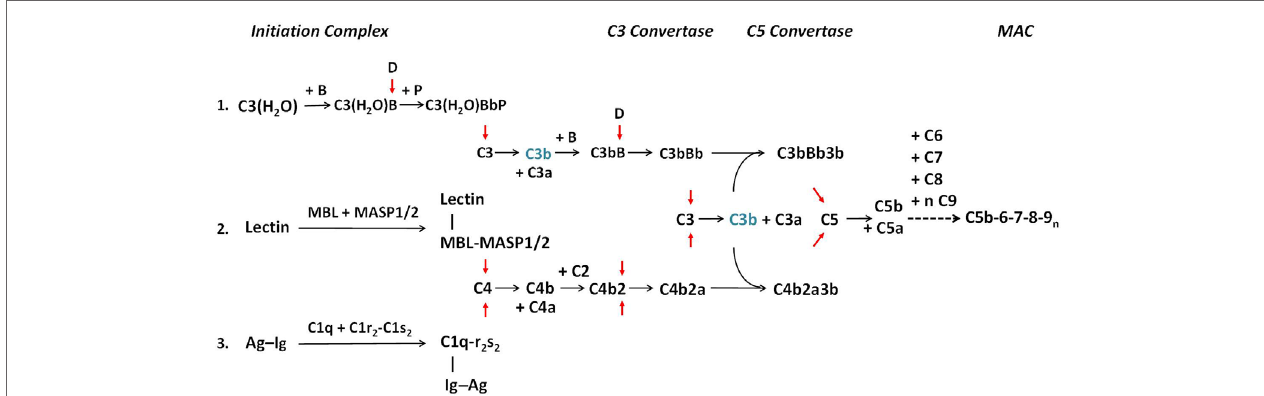
FiGURe 1 | The activation pathways of the complement system . The three activation pathways of the complement system are shown according to evolution and physiologic sequences. Pathway 1 is known as the alternative pathway. It is activated through a tick-over mechanism because of continuous hydrolysis of the thioester bond in C3, which enables the formation with factor B to form a weak C3 convertase. Pathway 2 is known as the MBL or lectin pathway. It is initiated through the binding of mannan-binding lectin (MBL) or ficolin to arrays of simple sugar molecules in glycosylated antigens on microbes. This is a pattern recognition mechanism characteristic of the innate immune system. Pathway 3 is known as the classical pathway and is initiated through the binding of specific antibodies IgM or IgG to antigens. It is an effector arm of the humoral adaptive immune system. Each activation pathway engages the formation of a multi-molecular initiation complex, followed by the assembly of a C3 convertase and a C5 convertase for activation of C3 and C5, respectively and culminates in the formation of membrane attack complexes (MAC) on the target membrane. All three pathways can be amplified through a positive feedback mechanism, as C3b (in blue) generated by any C3 convertase can feed to the alternative pathway through association with factor B to form new C3 convertase after activation by factor D (pathway 1). Anaphylatoxins C3a and C5a are produced during the activation process. For brevity, by-products generated during the activation of C2 and factor B are not shown. Red arrows show activation of component proteins through cleavage by serine proteases. A dotted horizontal arrow denotes multiple steps are involved in the formation of the membrane attack complex. Early components of the classical pathway C1q, C1r, C1s, and C4 are engaged in the differentiation of immunity and autoimmunity, as genetic or acquired deficiency in any of these components are linked to pathogenesis of SLE. Complement C2 is also involved in the protection against autoimmunity but its effect size is smaller [modified from Ref.